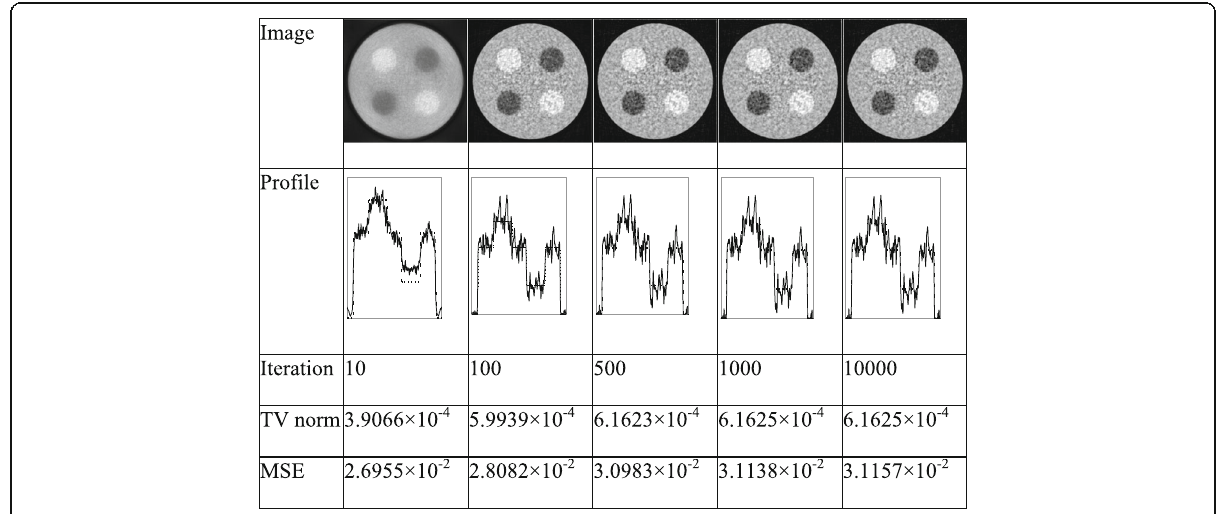
Fig. 8 Reconstructions of transmission data using algorithm (15) with β = 0.01 when I 0 =